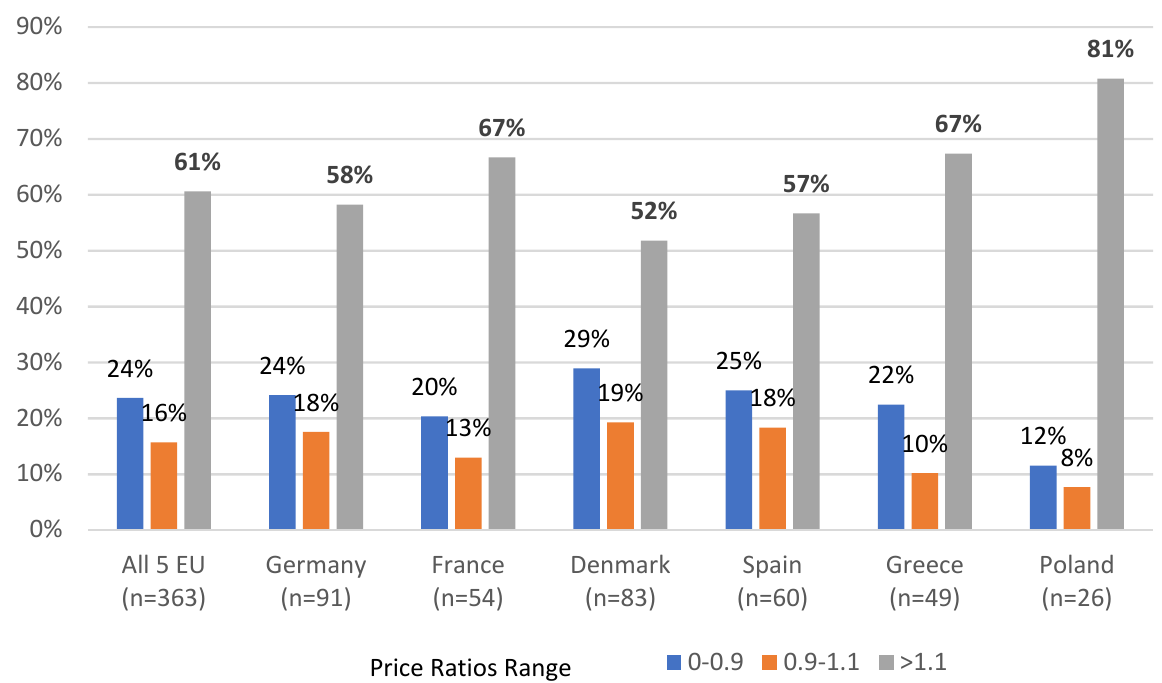
Figure 1. Distribution of VAFFS/EU Price Ratios per Country.